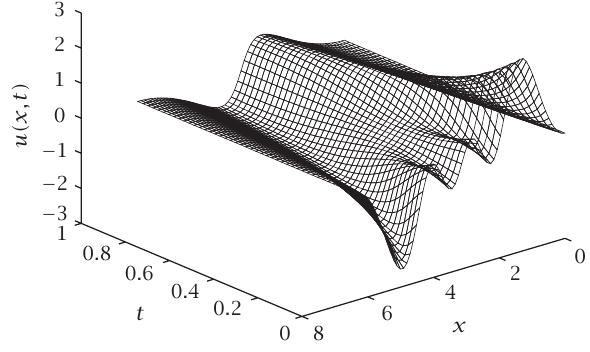
Figure 4.1 . Time evolution of the uncontrolled Burgers equation (3.1) when n = 1, m = 0 . 1, ν = 0 . 3, and (a,b,c,d) = ( 1 , 0 , 1 , 0 )